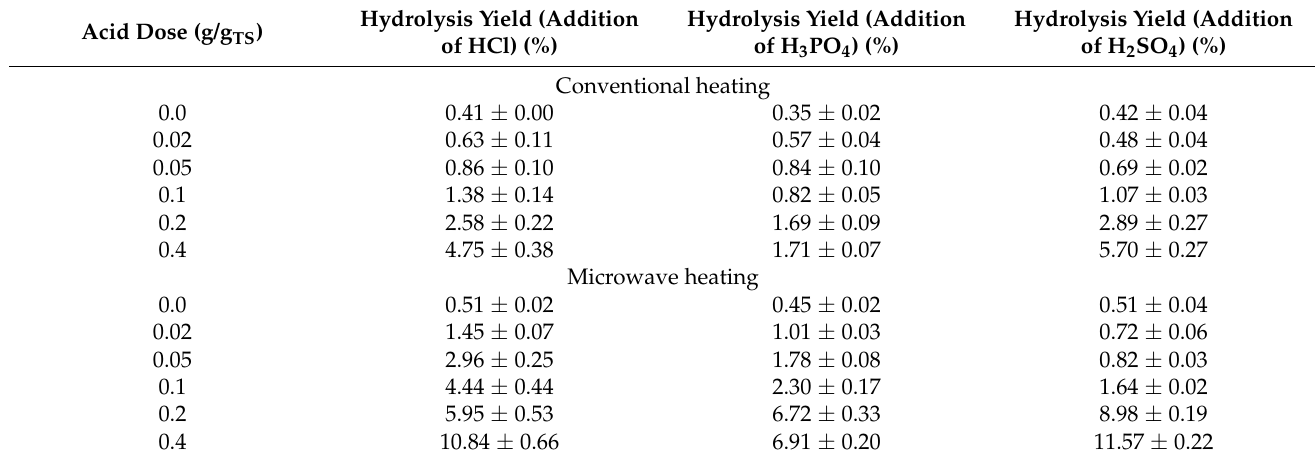
Table 3. Hydrolysis yield depending on heating method and acid